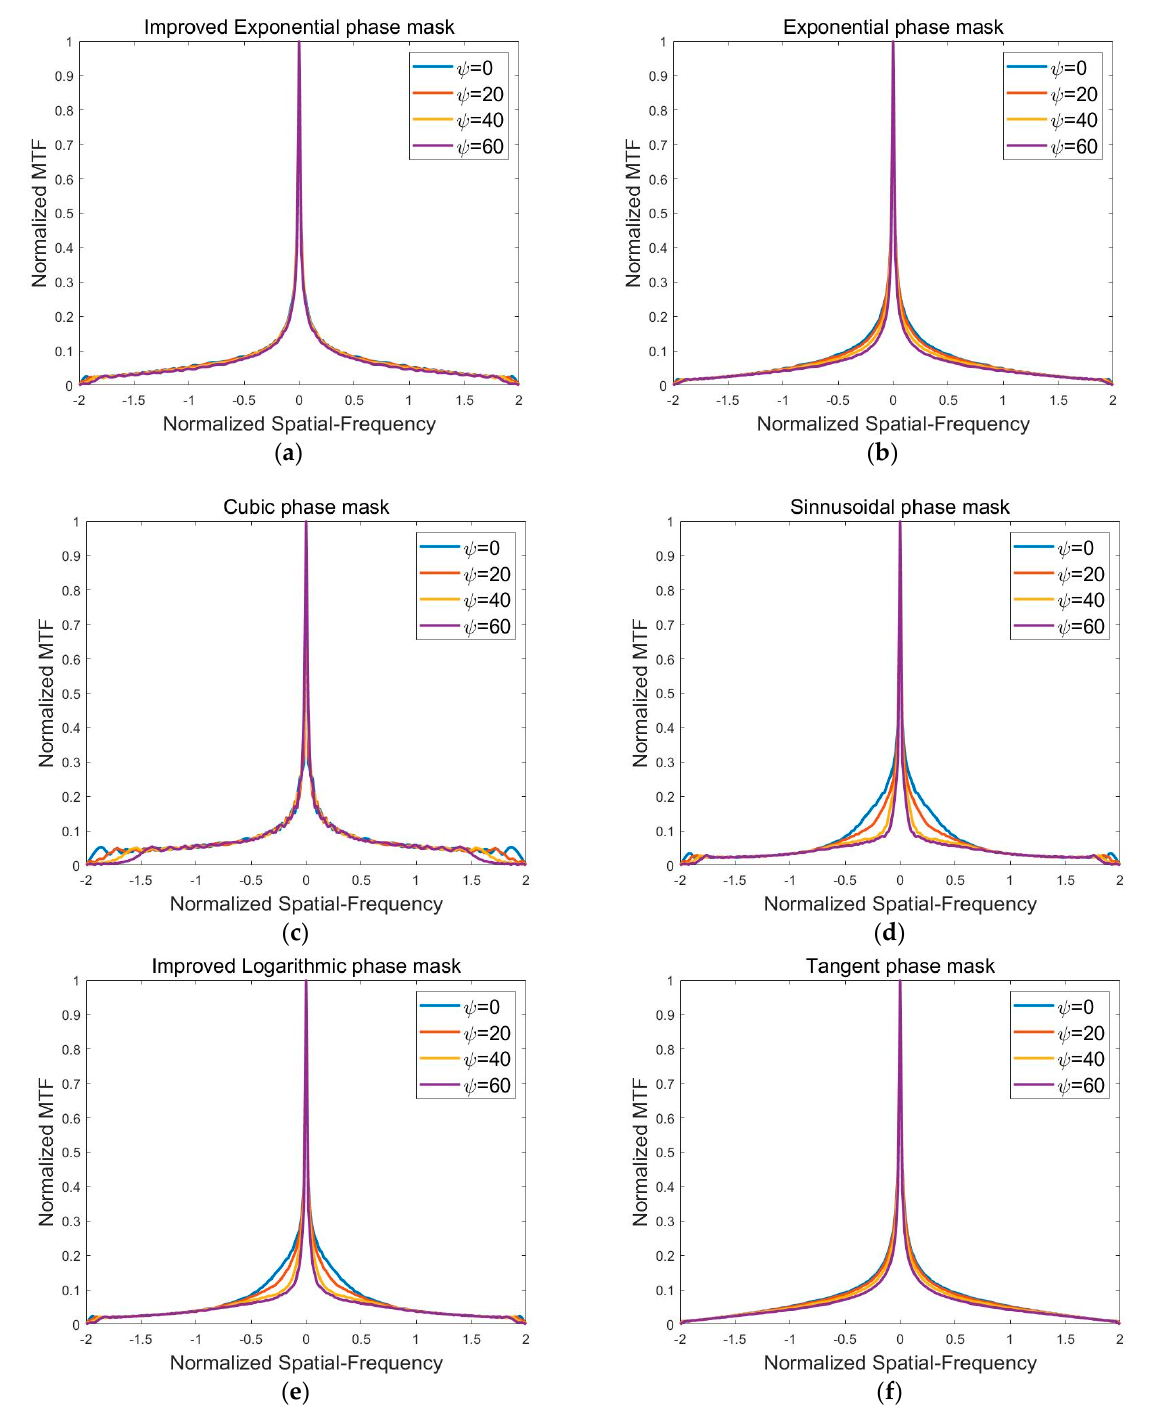
Figure 4. Defocusing MTF curves of six kinds of phase mask ( a ) Improved exponential phase mask ( b ) Exponential phase mask ( c ) Cubic phase mask ( d ) Sinusoidal phase mask ( e ) Improved logarithmic phase mask ( f ) Tangent phase mask.